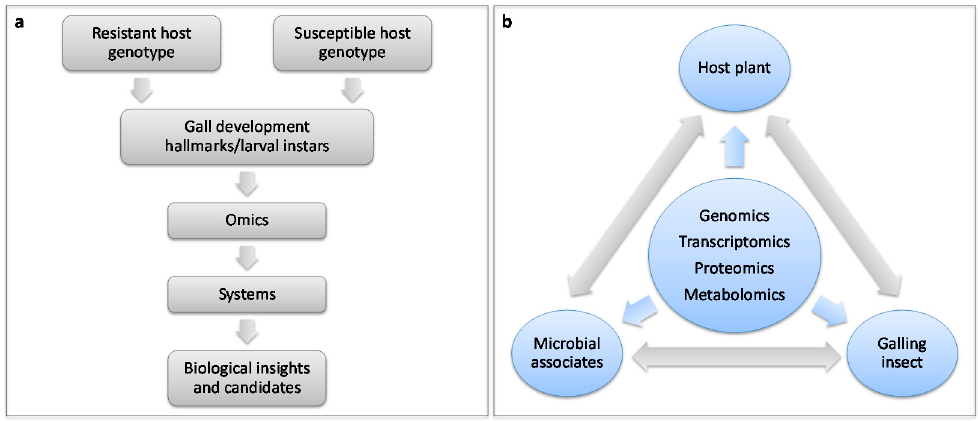
Figure 2. Simplified setup of a model plant-galling insect interaction and integration of multi-omics data to interrogate the interactome within and between plant-insect-microbial players during gall formation. ( a ) The development of a model system enables predictions of important candidates that are subsequently validated and used to improve the model. This resource subsequently facilitates non-model research by enabling comparative analyses; and ( b ) the integration of multiple omics datasets provides a means of interrogating the interactome within and between plant–insect–microbial players during gall formation.